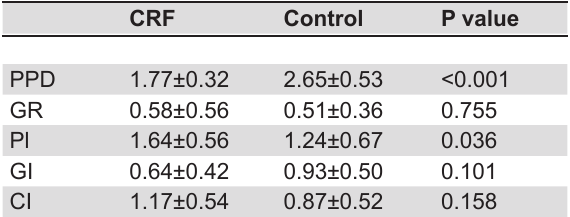
Table 2- Mean ± standard deviation of clinical parameters in patients with chronic renal failure (CRF) and